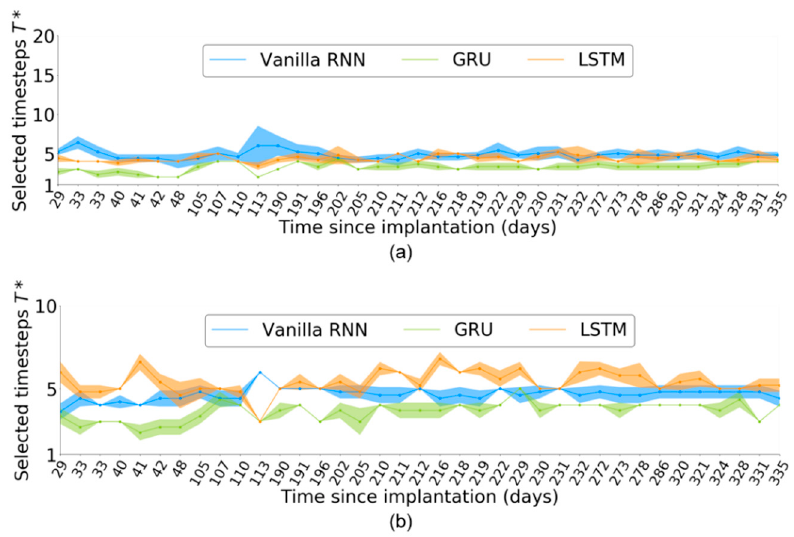
Figure 5. Number of selected timesteps, T ∗ , across 37 sessions corresponding to neural activity of length ( a ) T = 10 and ( b ) T = 20. The shaded areas represent the T ∗ distributions obtained from five independent runs per session.